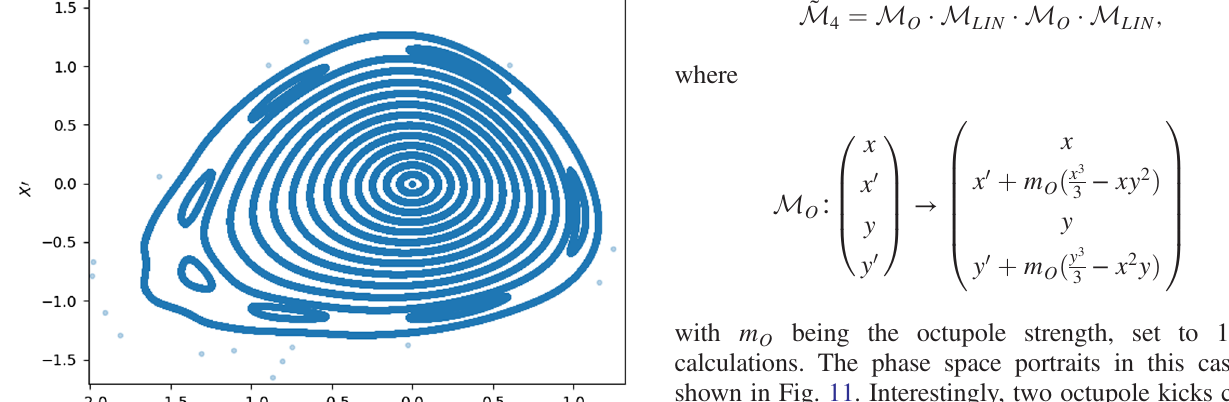
FIG. 9. Phase space portrait of map), μ x ¼ μ y ¼ 1 = 6 .